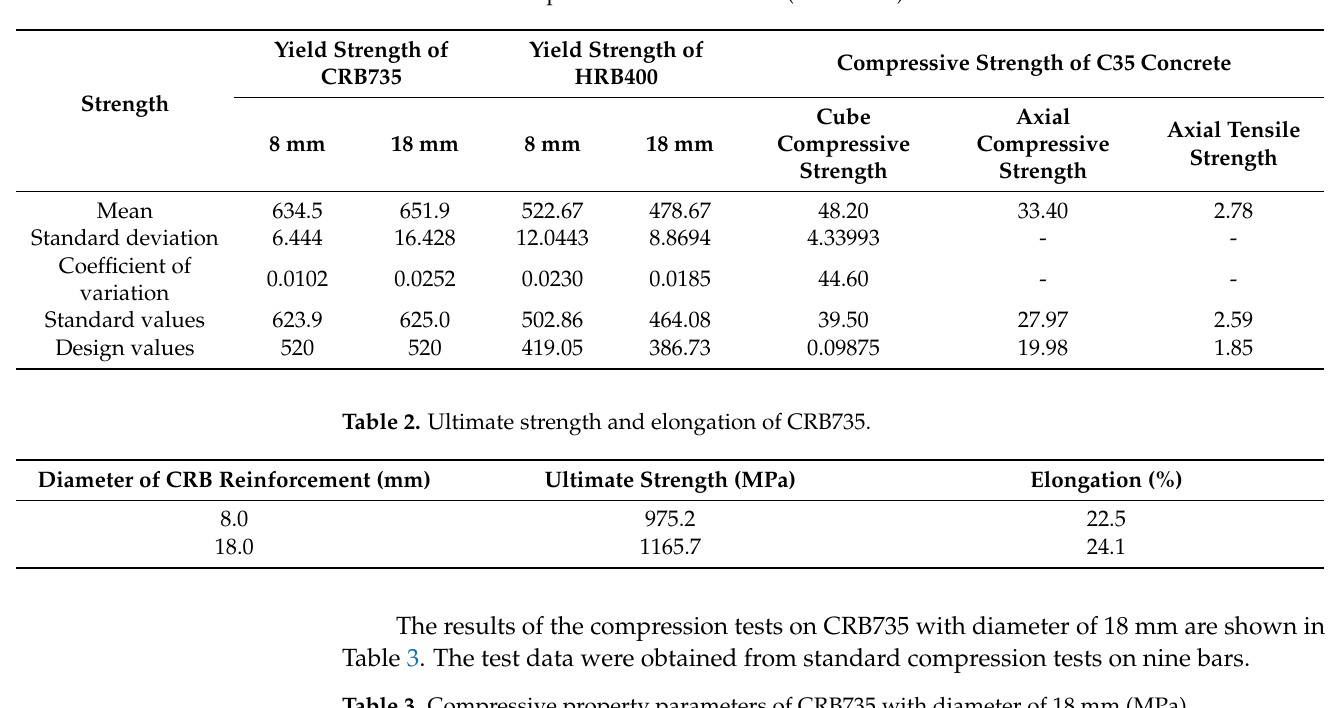
Table 1. Mechanical parameters of materials (Unit: MPa).